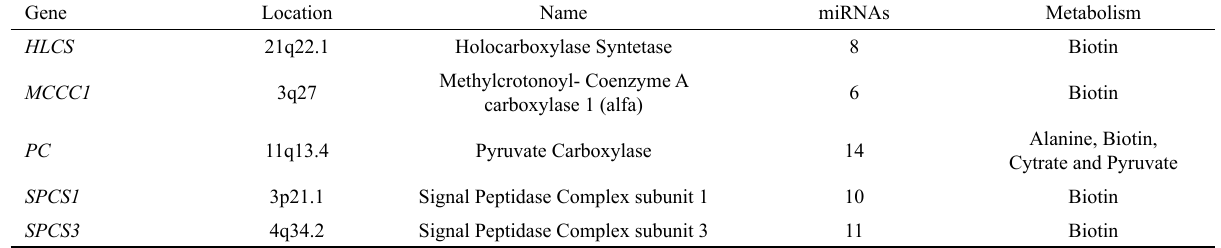
Table 5 – Genes involved in biotin metabolism and number of miRNAs predicted to influence the metabolic pathways of alanine, biotin, citrate and pyruvate. Gene